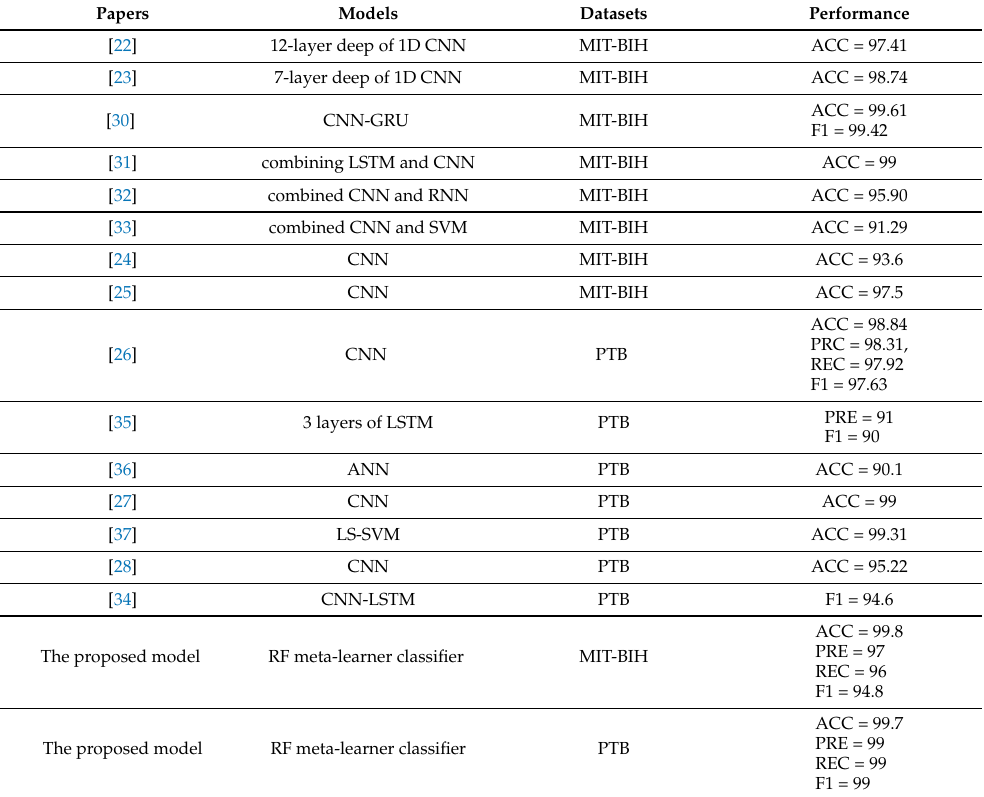
Table 9. Comparison of the performance of the proposed model with the previous